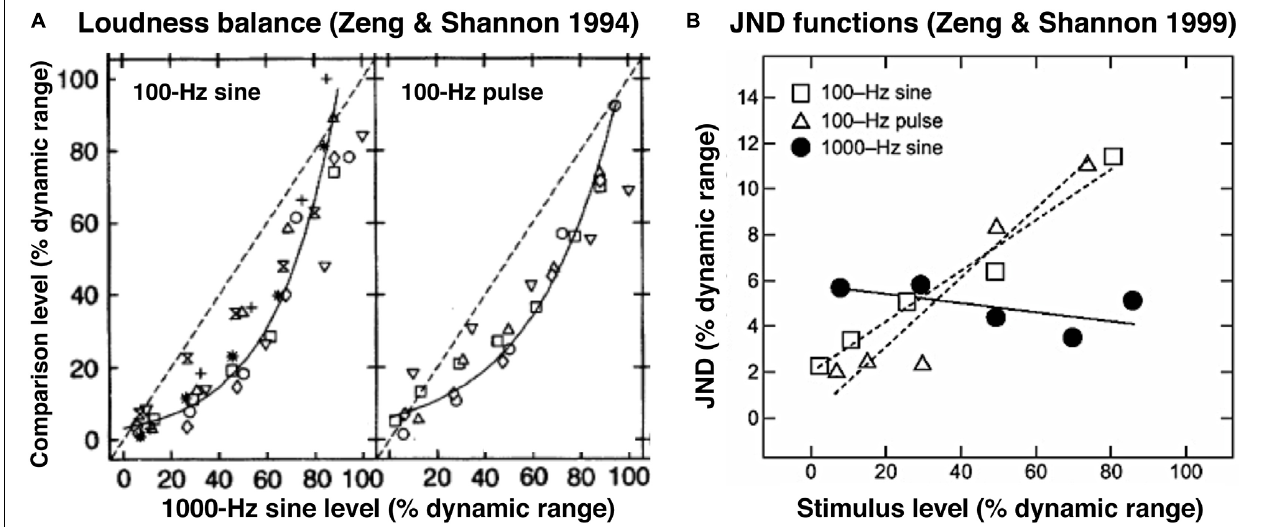
FIGURE 3 | Loudness balance (A) and JND functions (B) in cochlear implant users. (A) Loudness balance functions were obtained between 100-Hz sine or 100-Hz pulse and 1000-Hz sine electric stimuli, adapted from Figures 2D,E in Zeng and Shannon (1994). Reprinted with permission from AAAS. Symbols represent individual data and the solid line represents a logarithmic balance function. The dashed line represents a linear balance function, which clearly was not the true. (B) JND data (symbols) and predicted functions (lines) using the same stimuli from the same subjects in (A) , adapted from Figure 4 in Zeng and Shannon (1999). Reprinted with permission from Wolters Kluwer